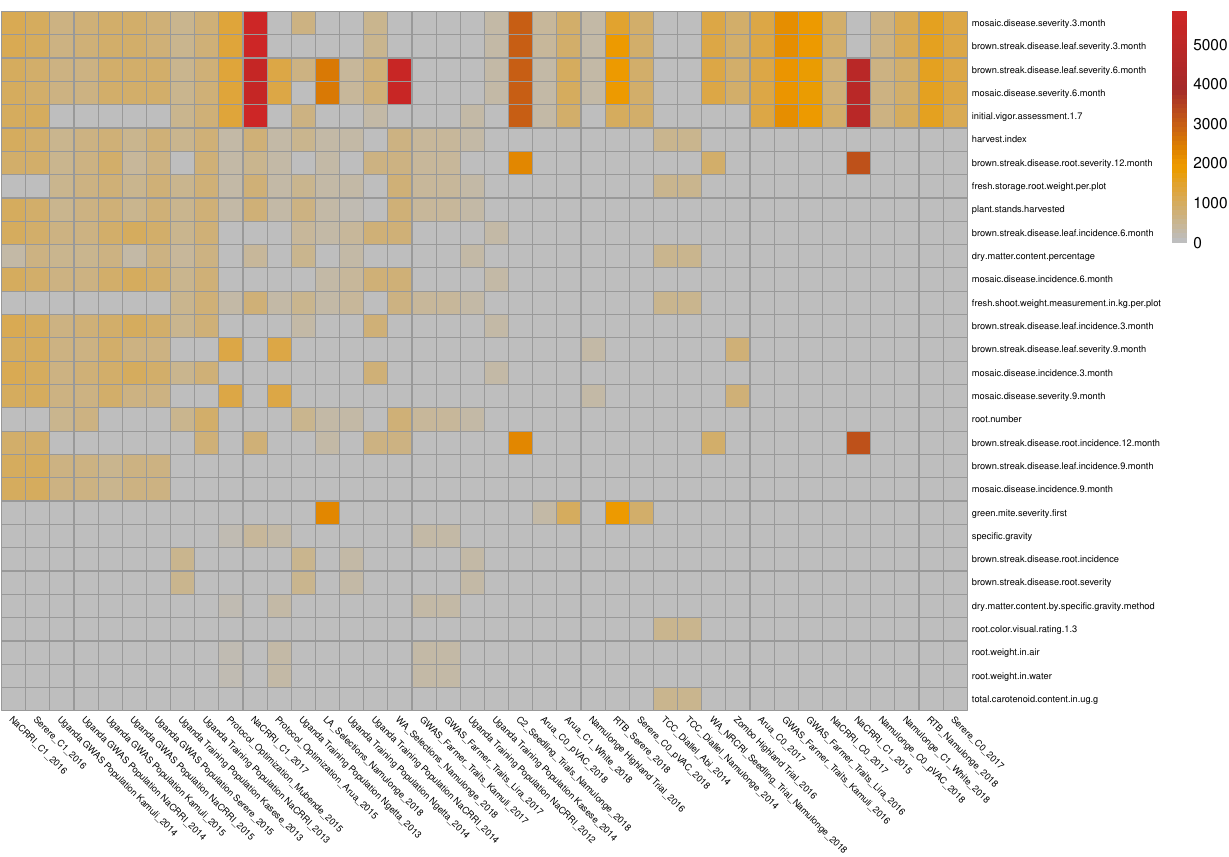
Figure 4. Illustration 4—This figure represents the availability of very unbalanced and heterogeneous phenotypic data for 37 traits in 50 trials in East Africa. The number of phenotypic records in each trial is represented with a colored box at the intersection of the trait (rows) and trial (columns). Gray squares represent unobserved traits and trial combinations. The mean number of traits observed in these studies was 10.38. Certain trait combinations were not observed together in these experi- ments; for example, root weight in water and dry matter content percentage, root number, and total carotenoid